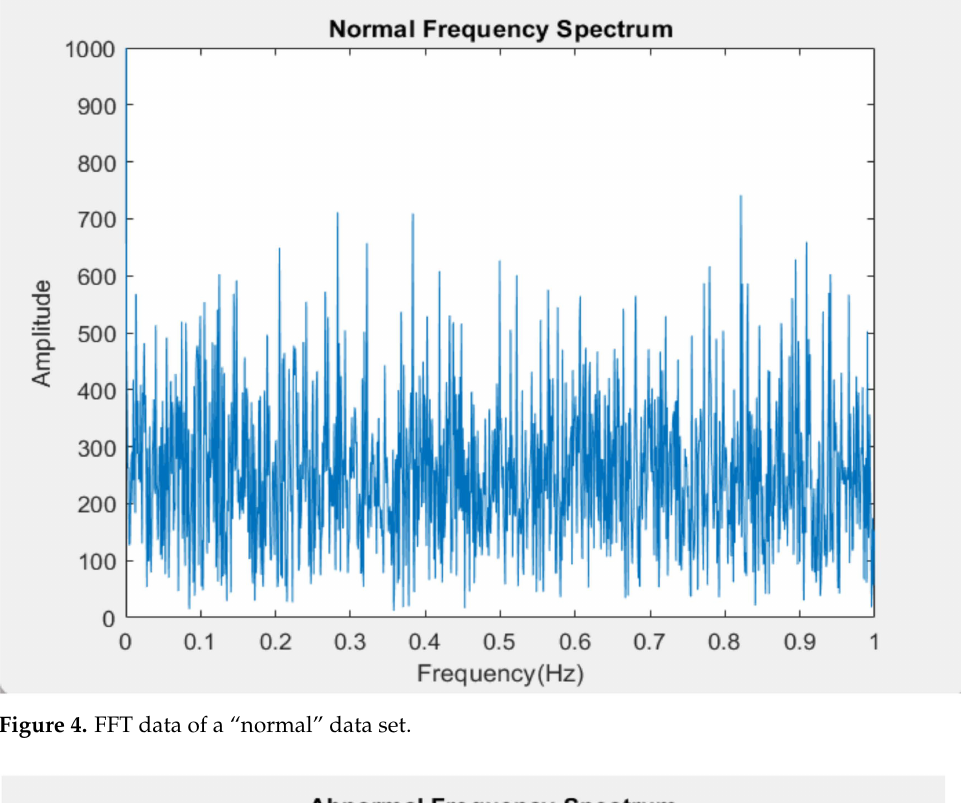
Figure 4. FFT data of a “normal” data set.